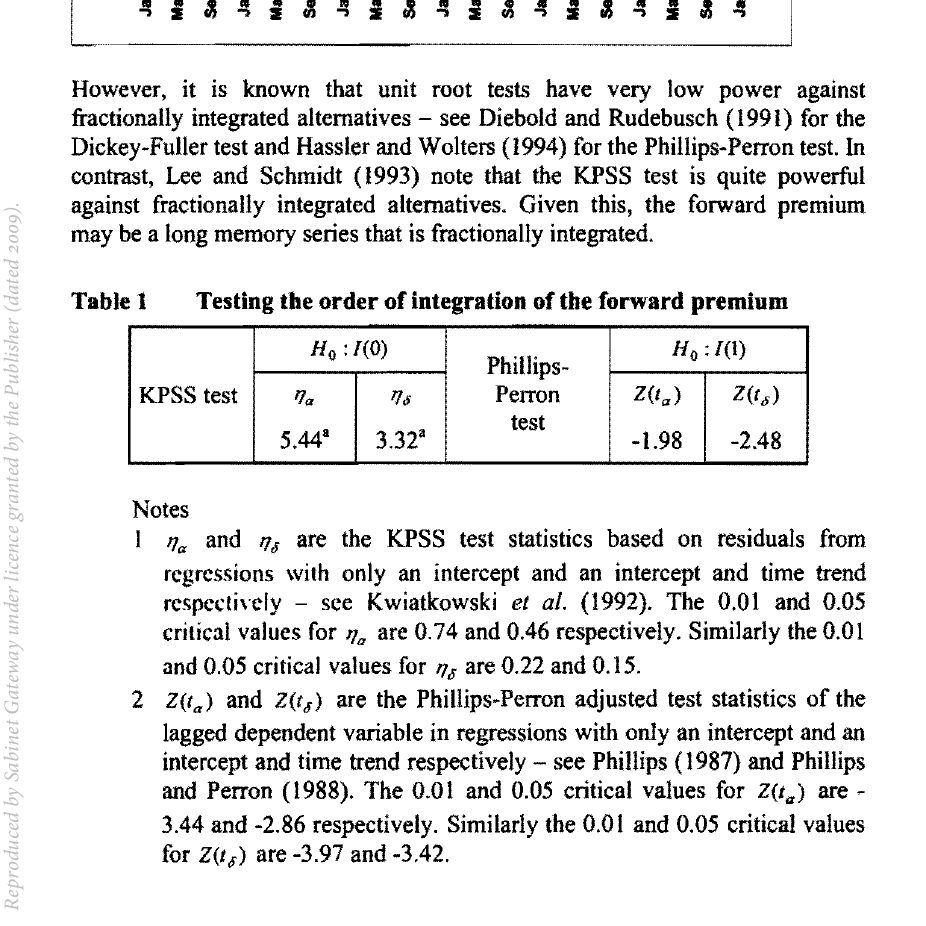
Testing the order of integration of the forward premium Ho : 1(0) Ho : [(1) Phillips- KPSS test